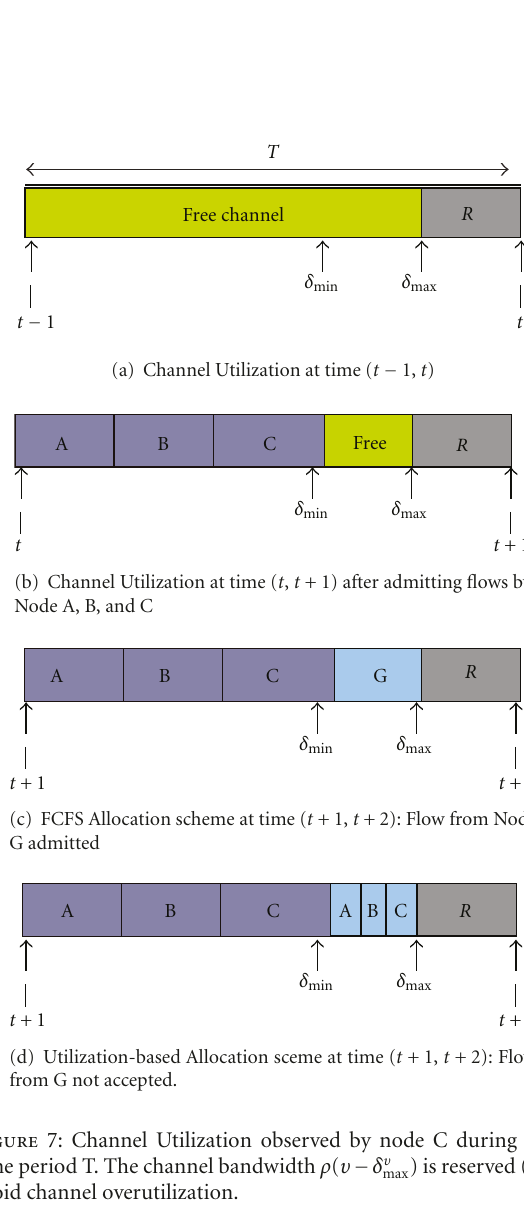
) is reserved ( R ) to max